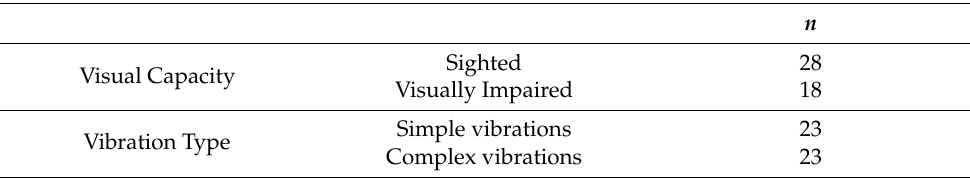
Table 1. Distribution of subjects according to their visual capacity and the vibration type used in the EXT